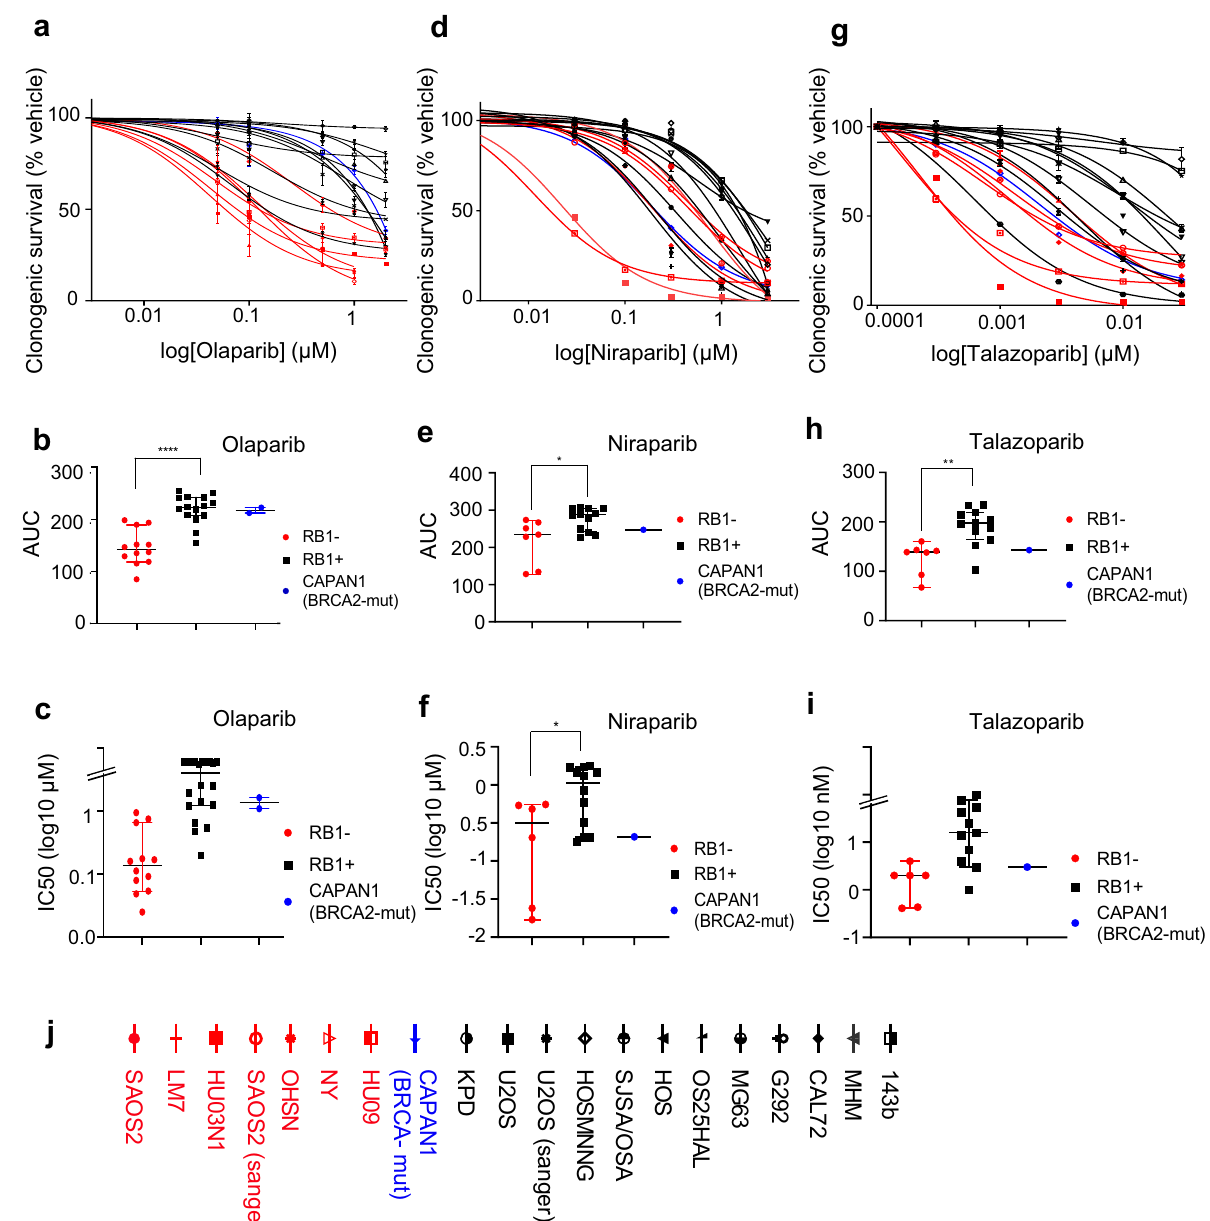
Fig. 2 Effect of PARP inhibition on clonogenic survival. Cells were seeded at low density into six-well plates followed by treatment with increasing concentrations of PARP inhibitors or vehicle. Colonies arising were stained using crystal violet dye. Clonogenic survival was quanti fi ed using dye extraction. Clonogenic survival concentration-response curves for RB1-defective (red) or RB1-normal (black) osteosarcoma and BRCA2 -mutant CAPAN1 (blue) after treatment with a olaparib, d niraparib, or g talazoparib. Data re fl ect the mean ± SD of parallel duplicates from one dataset. Scatter plots comparing AUC values for RB1-defective or RB1-normal osteosarcoma lines and BRCA2 -mutant CAPAN1 treated with b olaparib, e niraparib or h talazoparib summarising data for n = 2 ( b ) or n = 1 ( e , h ) biologically independent dataset. Bars depict median ±95% CI. * p < 0.05, ** p < 0.01, **** p < 0.0001 calculated using two- tailed Mann – Whitney tests, p ( b ) < 0.0001, p ( e ) = 0.022 and p ( h ) = 0.0012. c , f , i Scatter plots depicting IC50 values deduced from dose response data in b , e and h . Bars depict median ±95% CI; p ( f ) = 0.032*, calculated using two-tailed Mann – Whitney tests. j Symbols and names for cell lines used. Source data are provided as a Source Data fi Clonogenic assays, scoring for the ability of cells to form damaged chromatin 26,27 , (Fig. 1i, j), with signi fi cant correlation colonies, con fi rmed selective PARPi hypersensitivity in RB1- comparing repeat assessments (Supplementary Fig. 1j). However, defective osteosarcoma for all three PARPi (Fig. 2a – j, raw data the differential in sensitivity was small and the inhibitor Supplementary Fig. 2a – c) with half maximal inhibitory concen- concentration required to affect viability high. While consistent trations (IC50) for RB1-defective osteosarcoma matching or with an increased dependency on PARP1,2 catalysis, these results below that determined for BRCA2 -mutant CAPAN1, and indicate that PARP trapping may be an important mechanistic differentials in median IC50 value comparing RB1-normal and determinant for single-agent potency in RB1 -mutant osteosar- RB1-defective groups of 14-fold (olaparib), fi vefold (niraparib) coma, as is known for BRCA1,2 -mutated cancers 22 .